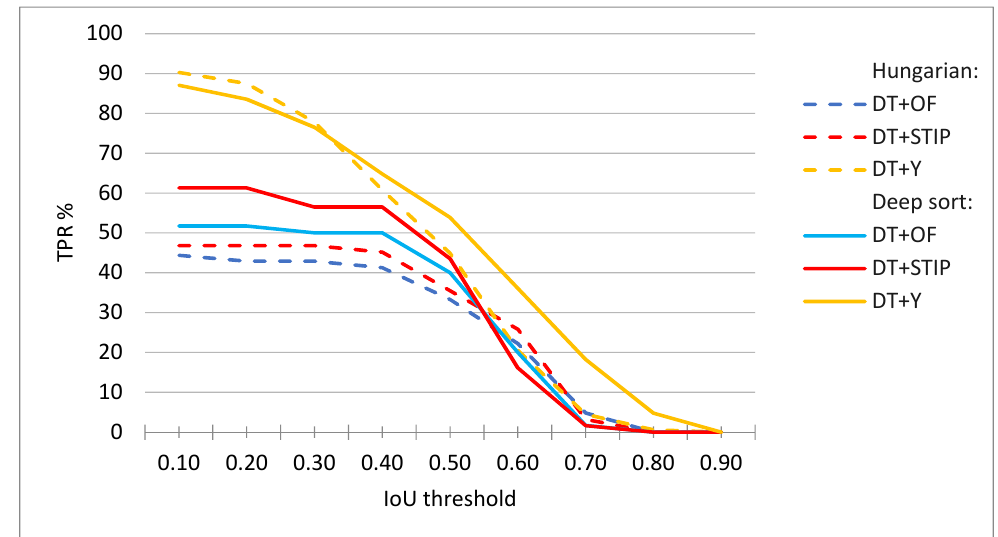
Figure 16. Evaluation results for player tracks obtained with DT + OF, DT + STIP, and DT + Y activity measures using Deep sort or Hungarian algorithm for tracking. The results at minimum θ = 70% correct frames per sequence.